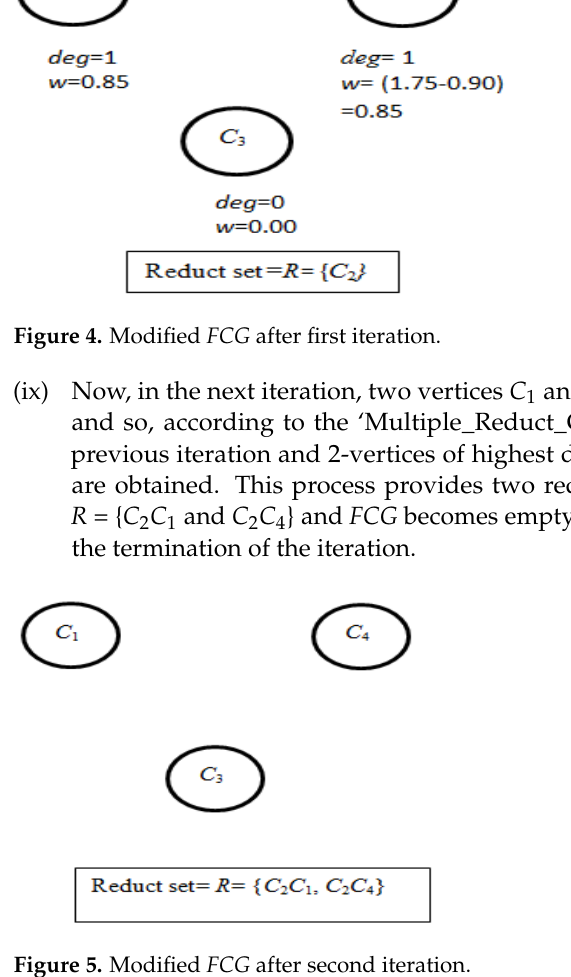
Figure 5. Modified FCG after second iteration.